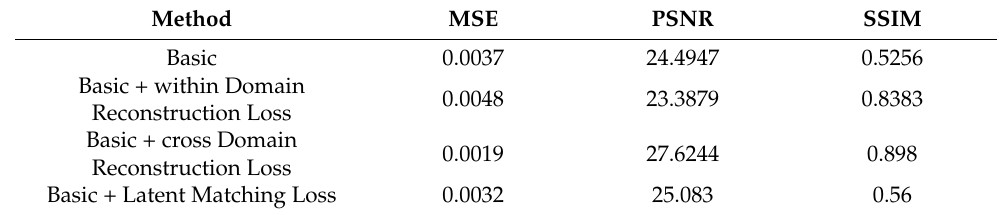
Table 7. Ablation study of the translation from visible spectrum domain to infrared spectrum domain.